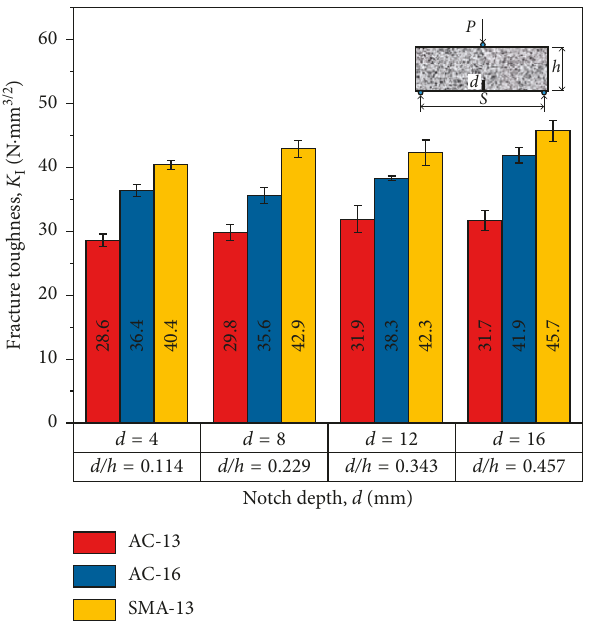
Figure 7: Fracture toughness for different notch depths.